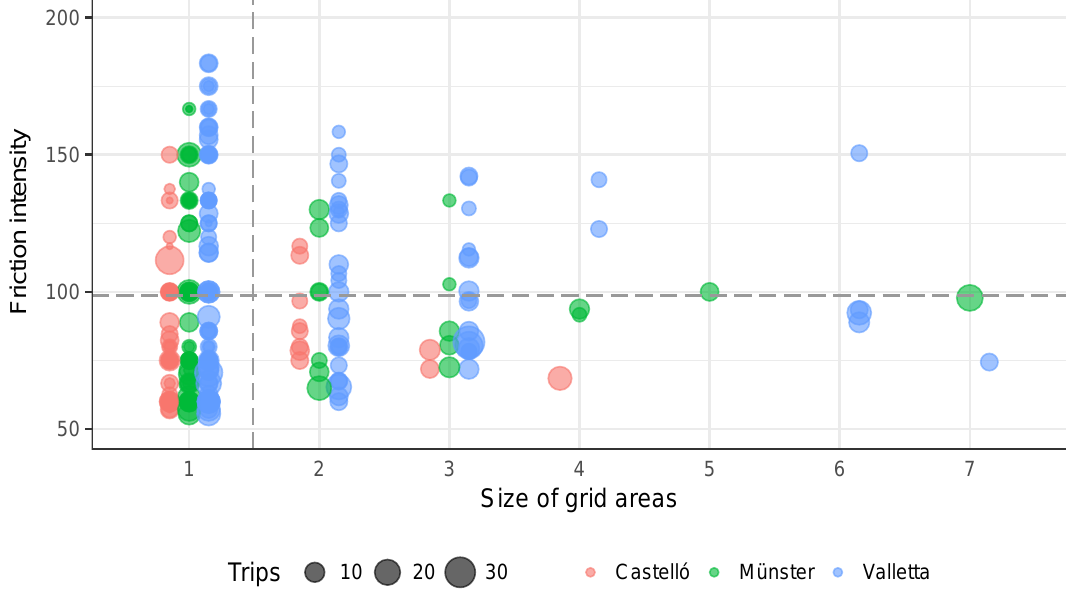
Figure 6. Aggregated third level frictions intensity and